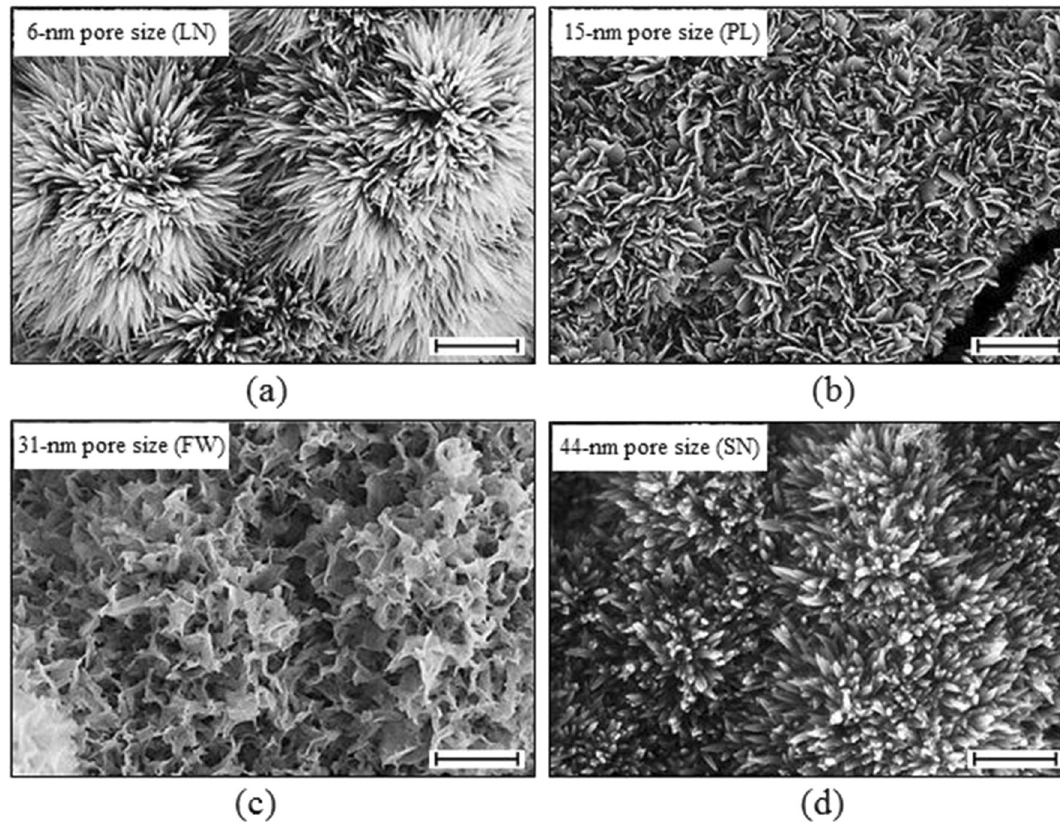
Figure 1. SEM micrographs of HA/CHA layer formed after 3 day PBS incubation on 30C70S nanoporous glass monoliths with different nanopore sizes yet similar specific surface area of 35 ± 2 m 2 /g. Long-needle (LN), plate- like (PL), flower-like (FW), and short-needle (SN) HA/CHA microstructures formed on ( a ) 6 nm, ( b ) 15 nm, ( c ) 31 nm, and ( d ) 44 nm pore-size 30C70S monoliths, respectively (scale bar = 1 µm). Reprinted from “Influence of nanoporosity on the nature of hydroxyapatite formed on bioactive calcium silicate model glass” by Thamma, U., Kowal, T. J., Falk, M. M. & Jain, H. J. Biomed. Mater. Res. Part B 107, p. 893 (2019). Copyright 2018 with permission from John Wiley and